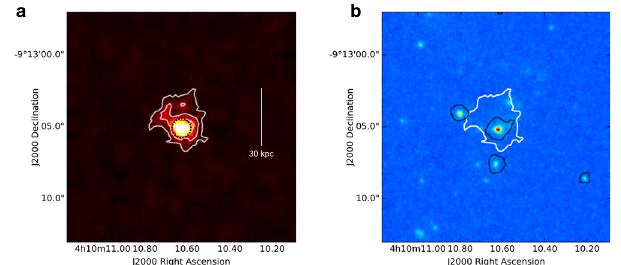
Fig.6|AsmallLyman- α nebula,possiblyassociatedtoW0410-0913.a Weshow anoptimallyextractedmapof thespatialdistributionofthenarrowandspectrally- offset Lyman- α emission emitted at the same location of the Hot DOG (see Fig. 5). We measure a spatial extension, de fi ned as the maximum projected linear size, of about 30kpc (see white line). The white contoursrepresent the [3, 5,10] σ levelsof signi fi cance, where the noise is estimated by propagating the variance and taking into account the number of layers contributing to each pixel in the 3D mask. The last contour at 3 σ de fi nes the spatial projection of the 3D mask. For display pur- poses,wehaveaddedtothemapoftheprojected3D-maskonewavelengthlayerof the cube corresponding to the centralwavelength of the nebula. b We show the 3 σ contour of the nebula overlaid onto the HST WFC3 F160W image. Black contours are located around galaxies in the cutout that are detected in MUSE continuum (obtainedcollapsingthefulldatacube)andarede fi nedastheregionsinwhich80% of the fl ux is